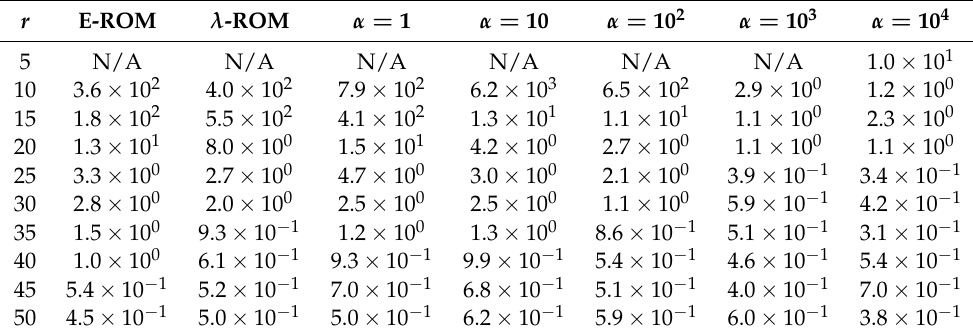
Table 2. Eulerian investigation, reconstructive regime: L 2 norm of the errors in the time-averaged streamfunction (22) for E-ROM (second column), λ -ROM (third column), and α -ROM for α = 1 (fourth column), α = 10 (fifth column), α = 10 2 (sixth column), α = 10 3 (seventh column), and α = 10 4 (eighth